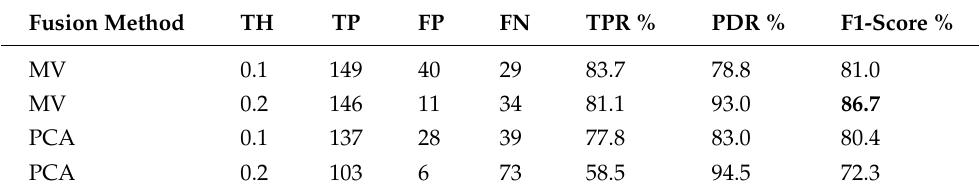
Table 1. Quantitative results from the change detection